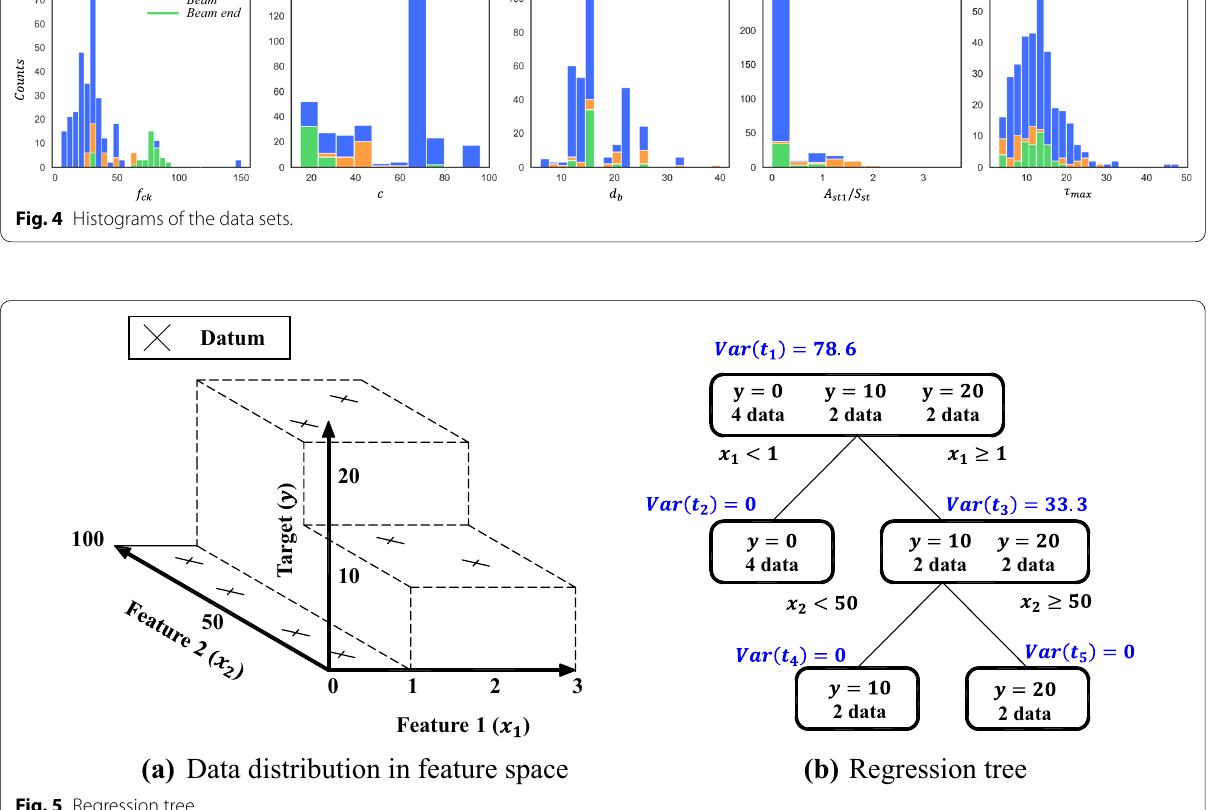
Fig. 5 Regression